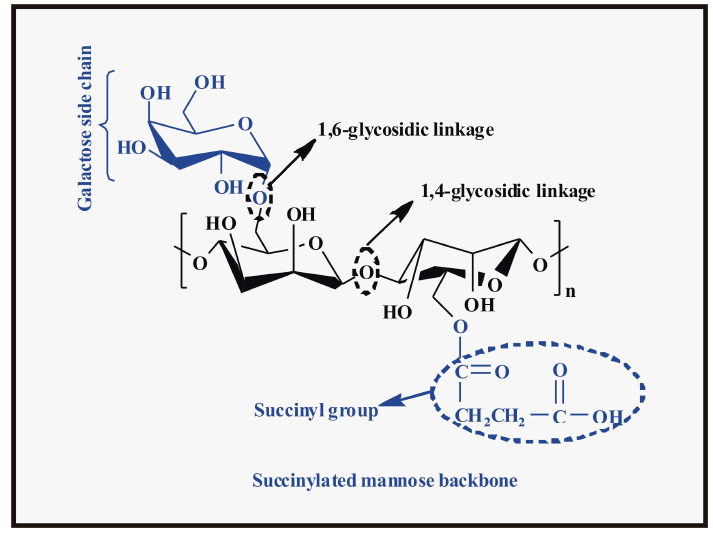
Figure 6. Structure of guar gum succinate.